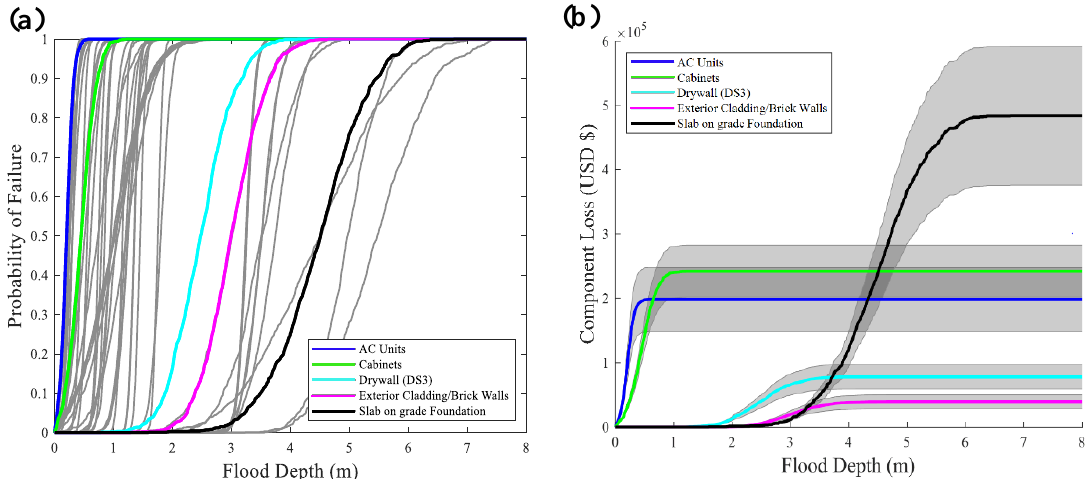
Figure 5. Components’ results for the F10 one-story school building archetype: ( a ) Components’ fragility curves; ( b ) Components’ loss curves.